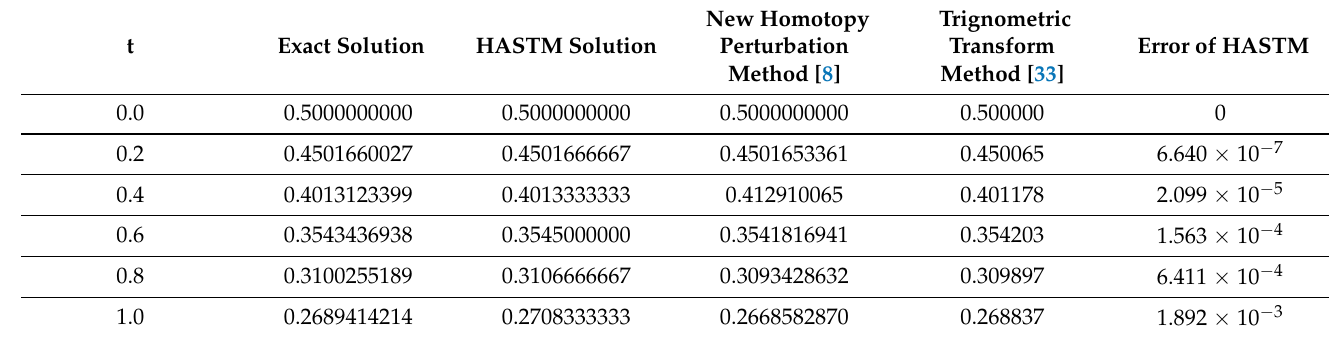
Table 2. Comparative analysis of the numerical results for u ( t ) at (cid:125) = − 1 and µ = 1 for Example 2.